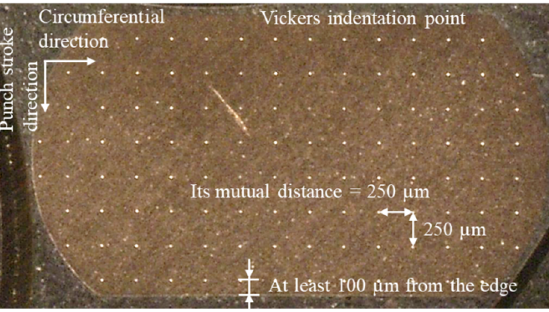
Figure 3. Generation of hardness mapping on the cross-section of forged works.